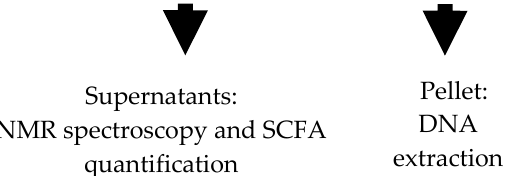
Figure 1. Fecal fermentation scheme. Each time point of the fermentation was done in triplicate except for the 0 h time point. A tube was prepared for the inoculum and was processed as the 0 h samples. Once each time point was reached, the appropriate number of tubes was removed from the warm room and fermentation stopped on ice. The ferments were centrifuged. The resulting supernatants were used for nuclear magnetic resonance (NMR) spectroscopy and short-chain fatty acids (SCFA) analysis by gas chromatography (GC). The resulting pellet was used for DNA extraction and sequencing.